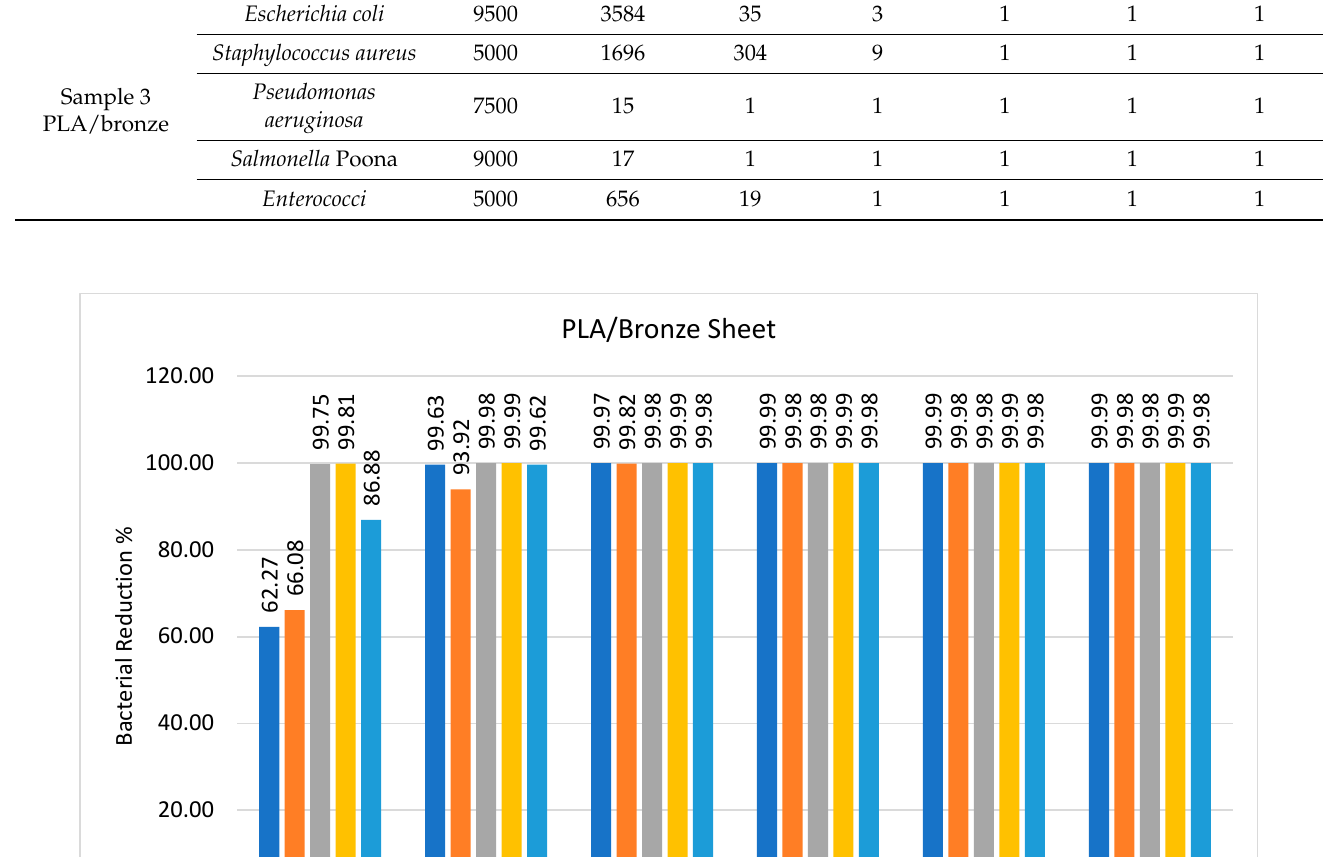
Table 4. Bacterial count on PLA/bronze sheet over different time intervals.